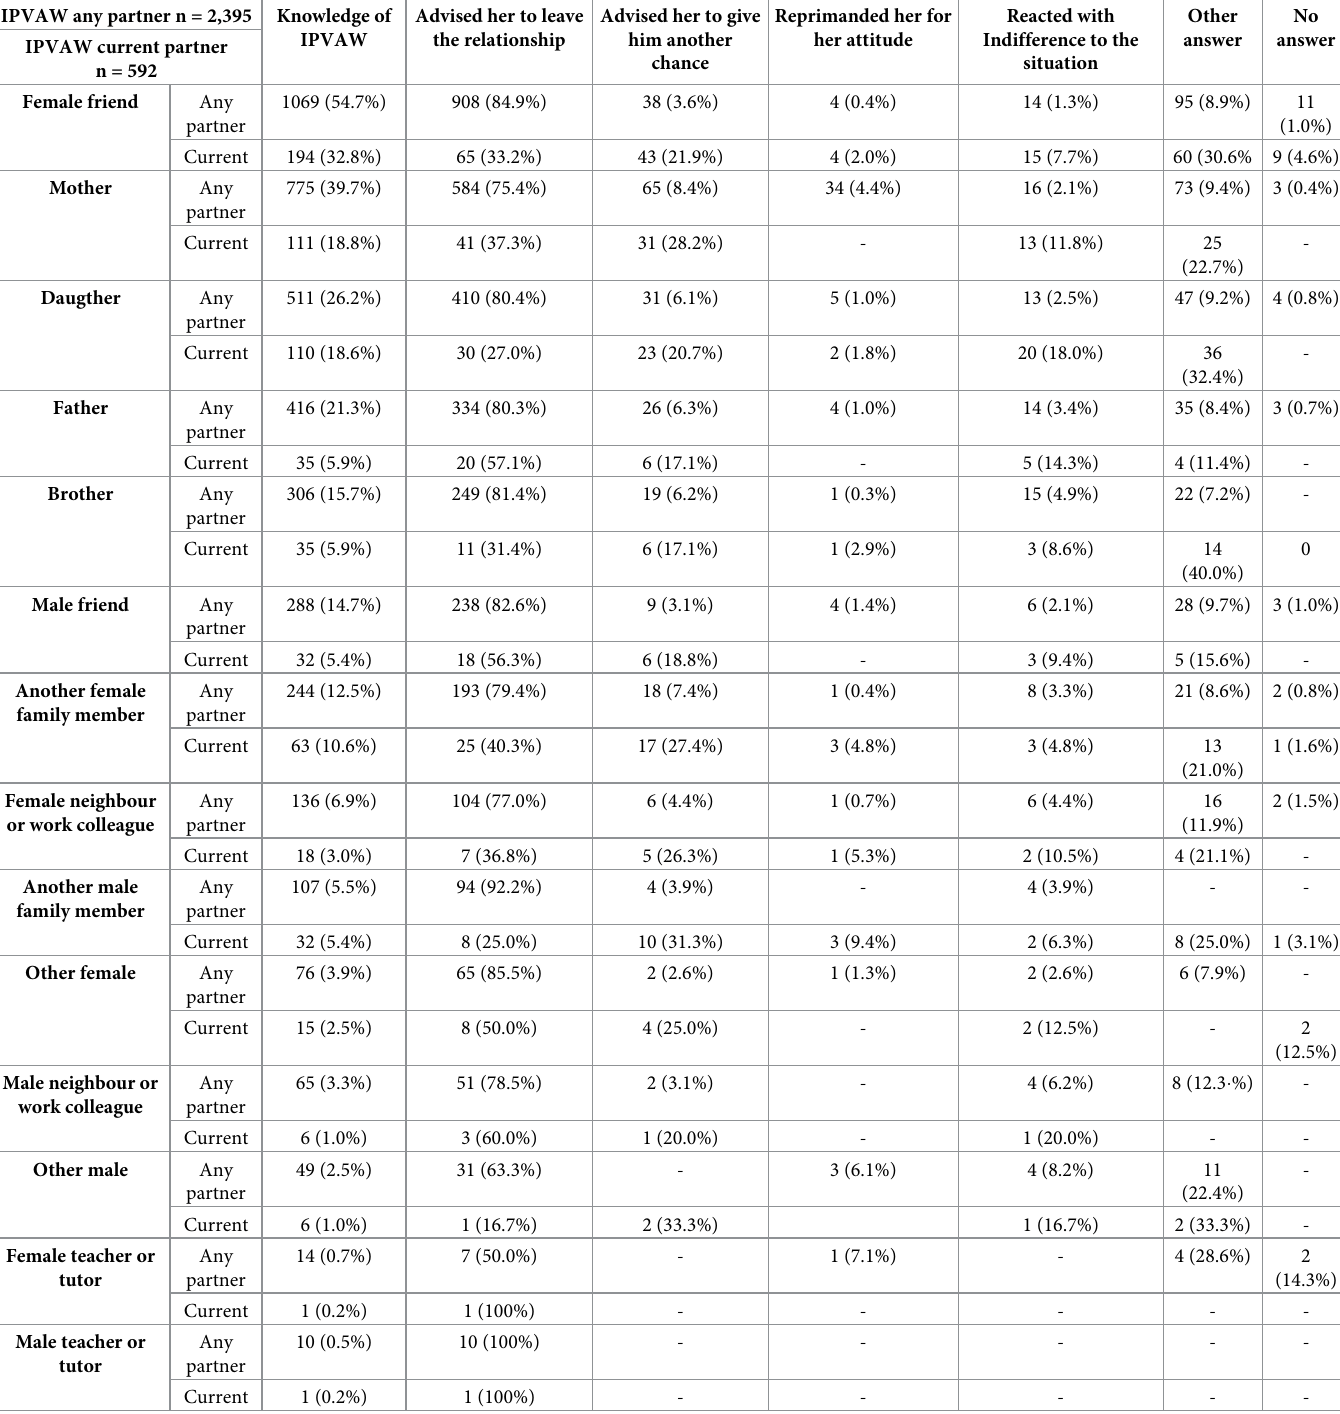
Table 4. Knowledge of IPVAW within the victim’s inner circle and their reactions. Macrosurvey 2019. IPVAW any partner n = 2,395 Knowledge of